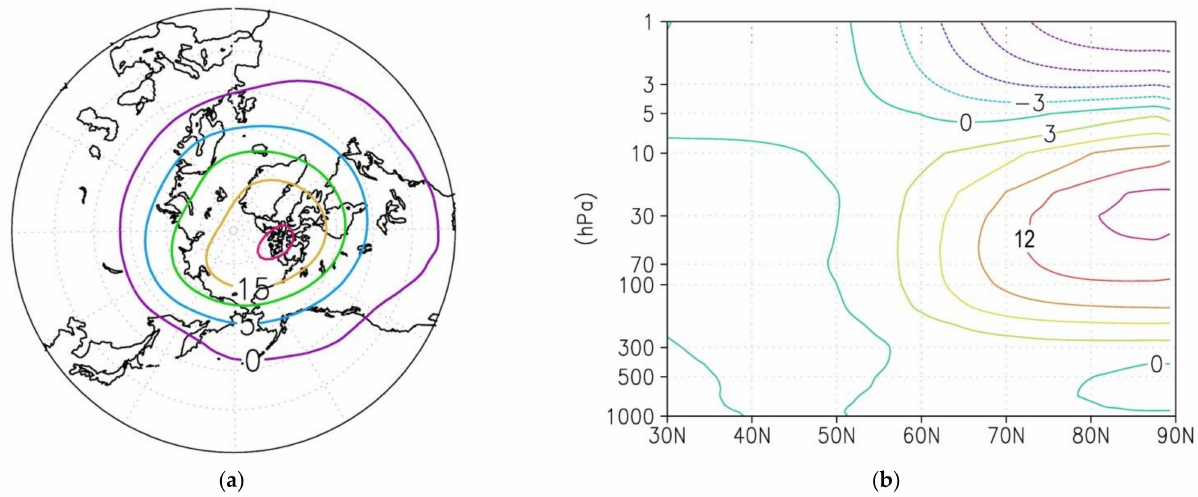
Figure 7. Difference in temperature at 70 hPa in January ( a ) and in zonal mean temperature averaged over December–February ( b ) between the “warm” and “cold”